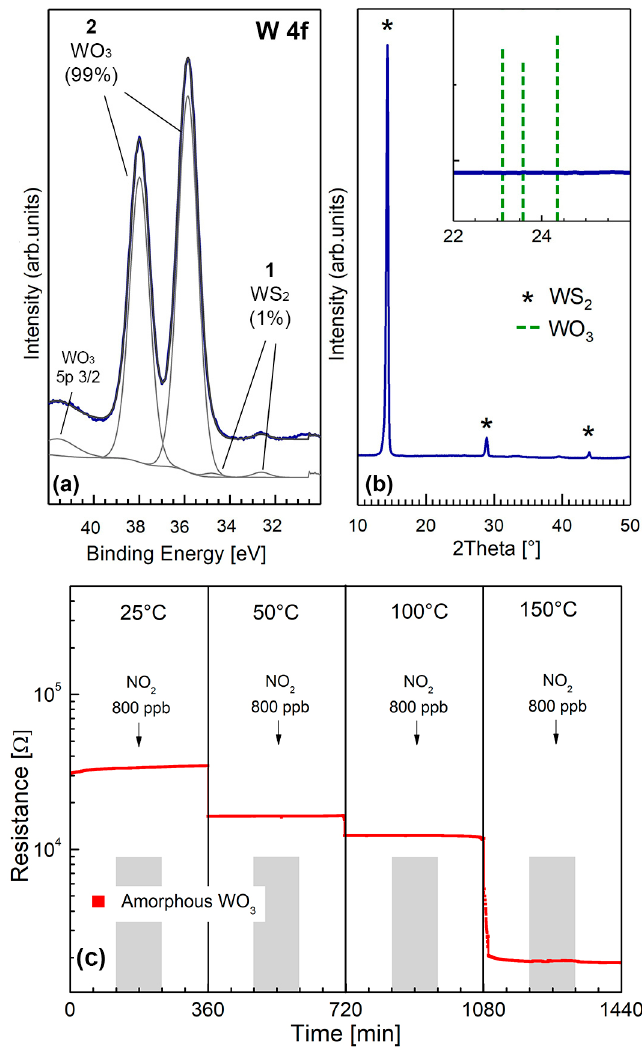
Figure 12. Chemical composition, crystalline structure and microstructural features of a fully oxidized WO 3 thin film. ( a ) W 4f core level XPS spectra, ( b ) XRD grazing incidence spectra. Top right inset shows the close up of the 2 θ region characteristic of crystalline WO 3 (corresponding peaks of crystalline WO 3 , according to ICDS 98-001-7003, are highlighted by dashed green lines), ( c ) electrical response of the fully oxidized WO 3 amorphous film to NO 2 and different OTs.